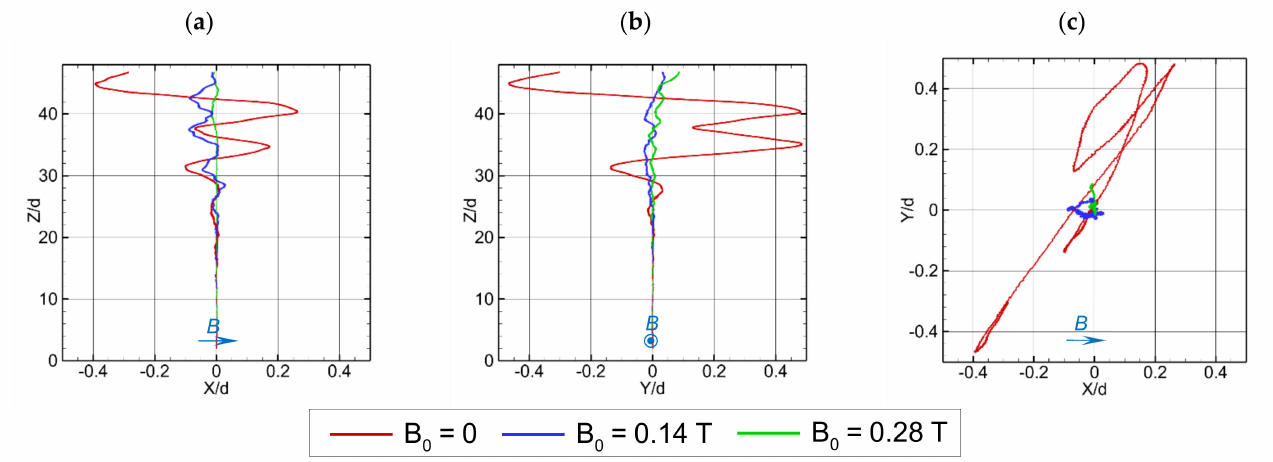
Figure 19. Trajectories of the rising bubbles for different magnetic field intensities in the ( a ) X–Z, ( b ) Y–Z and ( c ) X–Y planes. The trajectories become straighter with increases in B 0 . Comparing the blue lines in ( a , b ), the trajectory in the Y–Z plane is more rectilinear than that in the X–Z plane because the Lorentz force suppresses fluctuations in the x -direction more strongly than in the y